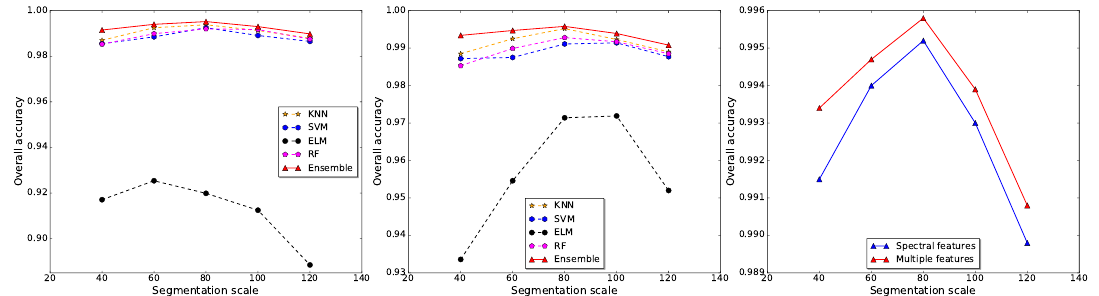
Figure 9. ( a ) Accuracies of OBCD with six spectral features and different classifiers for various segmentation scales; ( b ) accuracies of OBCD with multiple features and different classifiers for various segmentation scales; ( c ) accuracies of OBCD with EL and different feature selection strategies for various segmentation